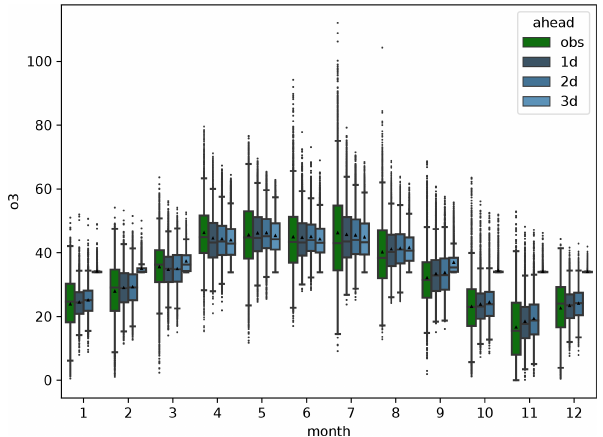
Figure 9. Graph of PlotMonthlySummary showing the obser- vations (green) and the predictions for all forecast steps (dark to light blue) separated for each